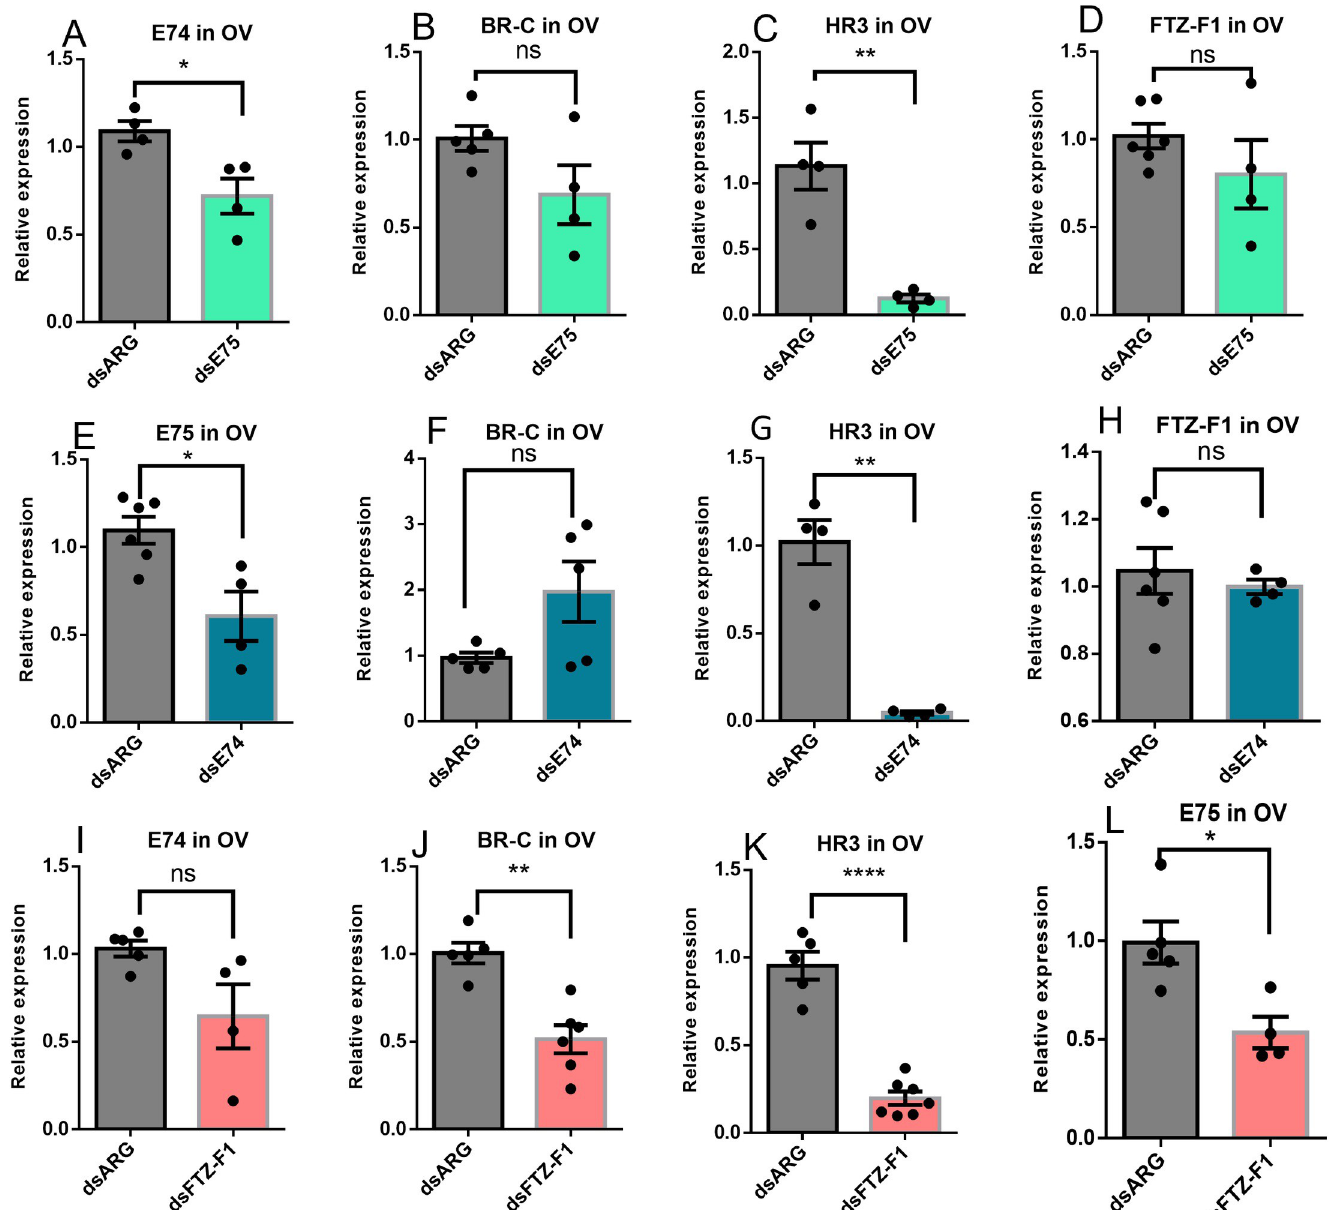
Fig 6. Effects of knockdown of E75 , E74 or FTZ-F1 on transcript expression of ecdysone response genes in the ovary of adult females 4 days post blood meal. Females were injected with dsRNA and blood fed as described in Materials and Methods. Relative transcript levels were measured using RT-qPCR and analyzed using the 2 − ΔΔ Ct method. Data are means ± SEM (n = 4–7). Rp49 and β -actin were used as reference genes. Statistical analysis was performed by Student’s t-test. � p < 0.05, �� p < 0.01, ���� p < 0.0001, ns = not